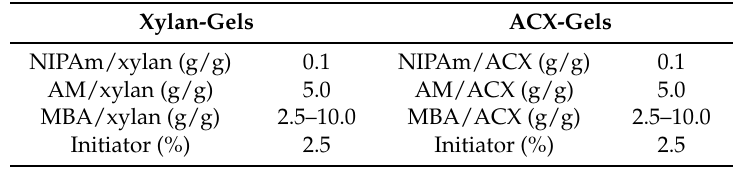
Table 1. Synthesis conditions of xylan-gels and ACX-gels.